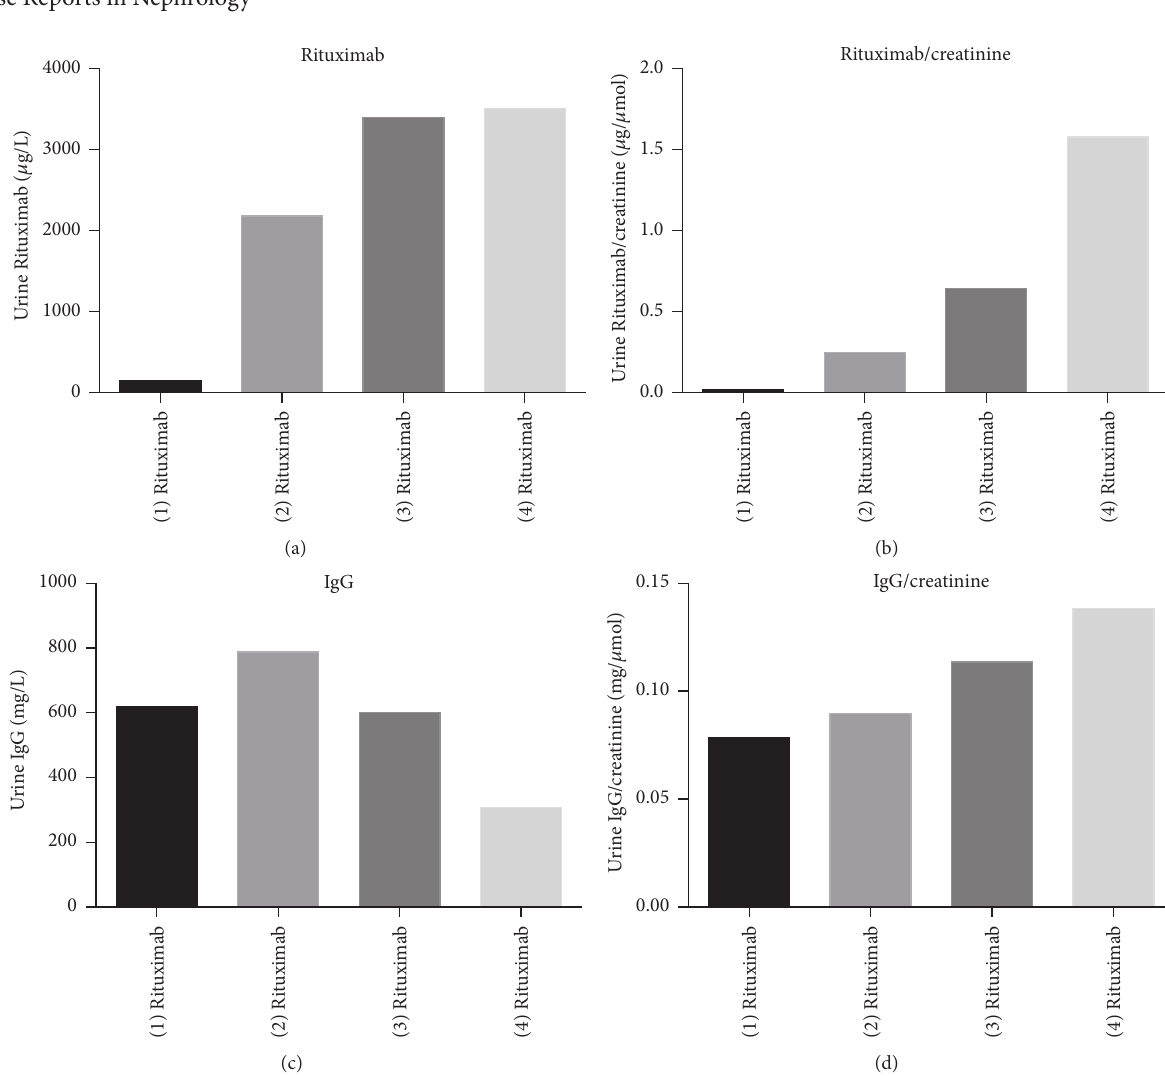
Figure 3: Rituximab urine concentrations (a), urine Rituximab/creatinine ratios as well as IgG urine concentrations (c), and IgG/creatinine ratios in the first